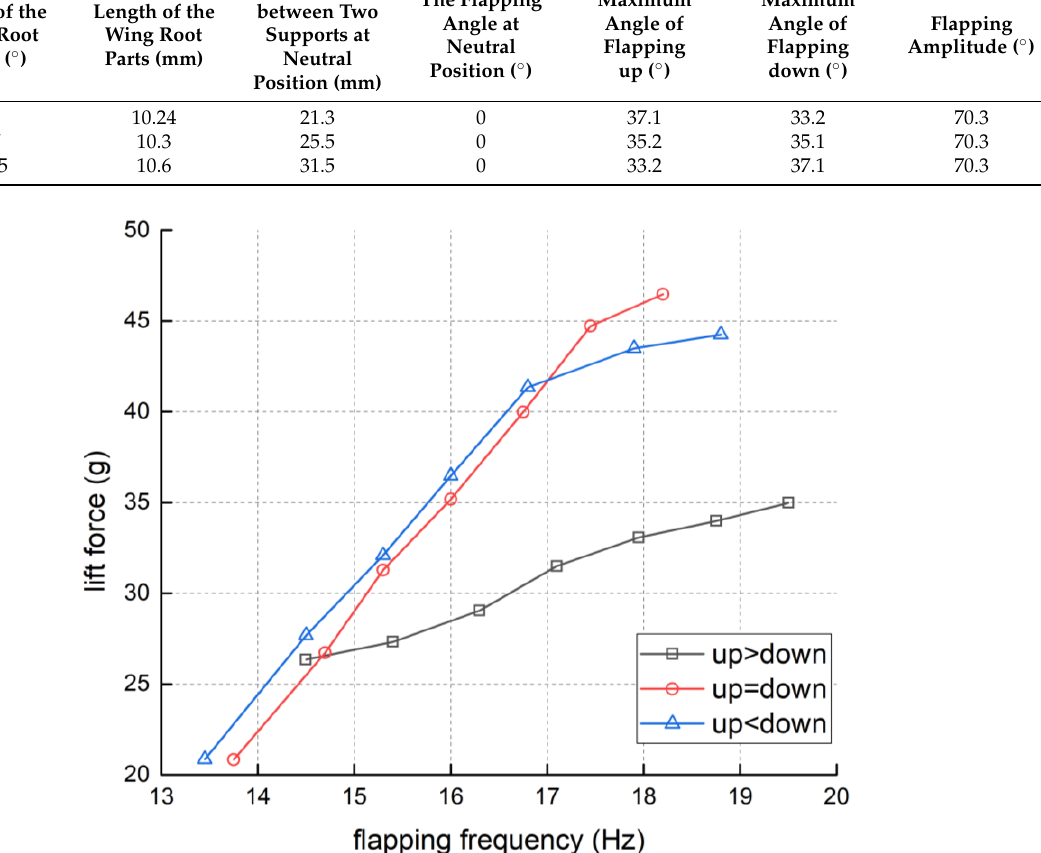
Figure 20. The flapping frequency-lift force line chart of the FWR with different maximum angles of flapping up and down.